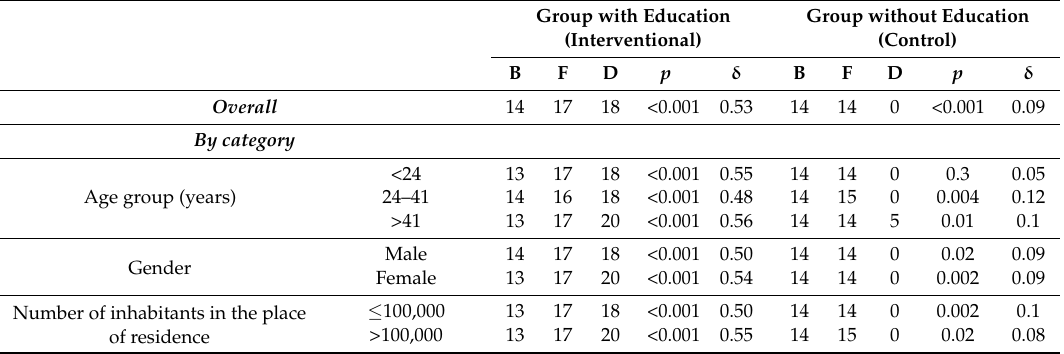
Table 3. Change in CKI scores in the control and intervention group with the effect